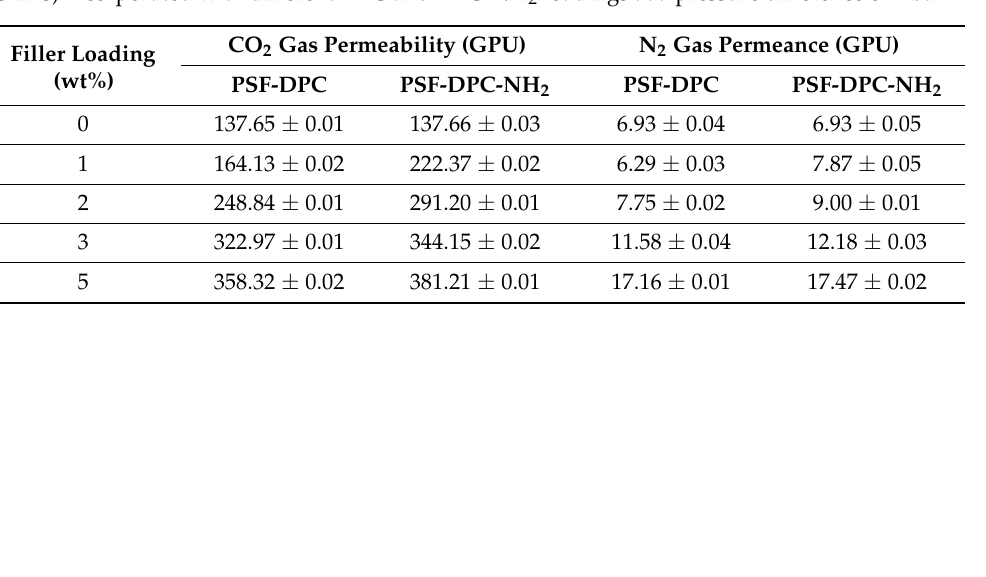
Figure 7. Optimum pressure for the coupled pristine PSF membrane. Table 2. CO 2 gas permeance and N 2 gas permeance of the composite (mixed matrix) membranes (CMBs) incorporated with different DPC and DPC-NH 2 loadings at a pressure difference of 4 bar.